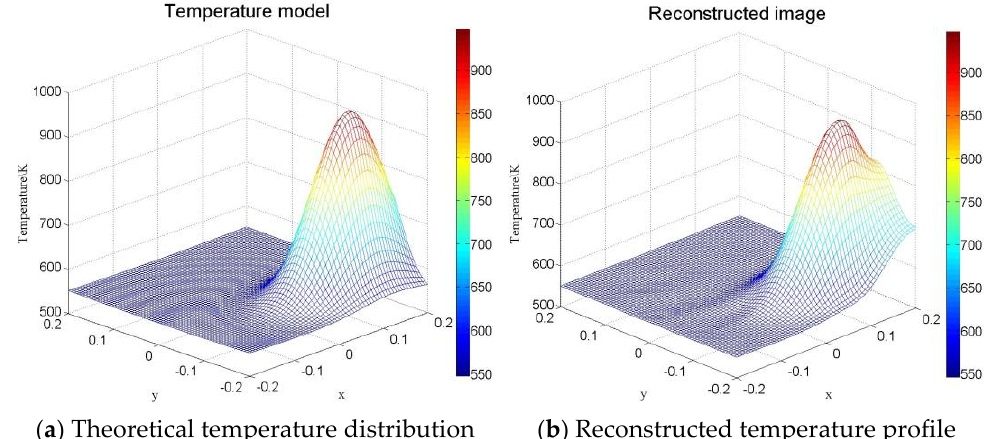
Figure 5 . Central – symmetric temperature distribution (Model I).